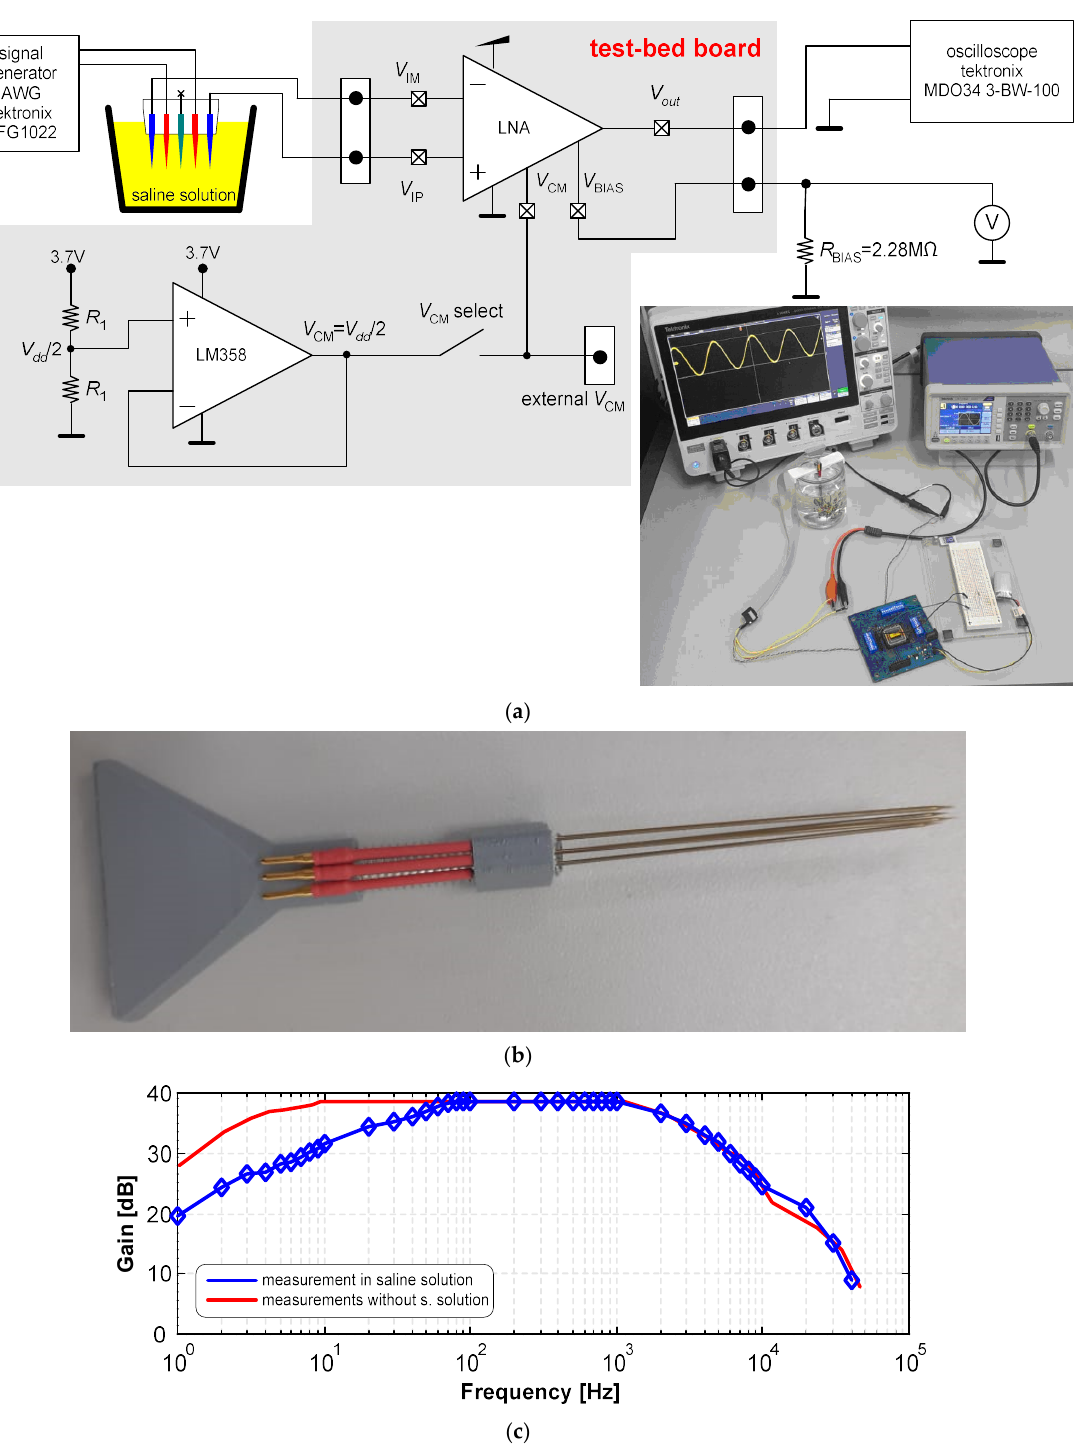
Figure 14. ( a ) Schematic of the saline solution setup. The inset shows the setup photograph. ( b ) Photograph of the 3D printed tip with the array of electrodes. ( c ) Measured gain of the LNA.